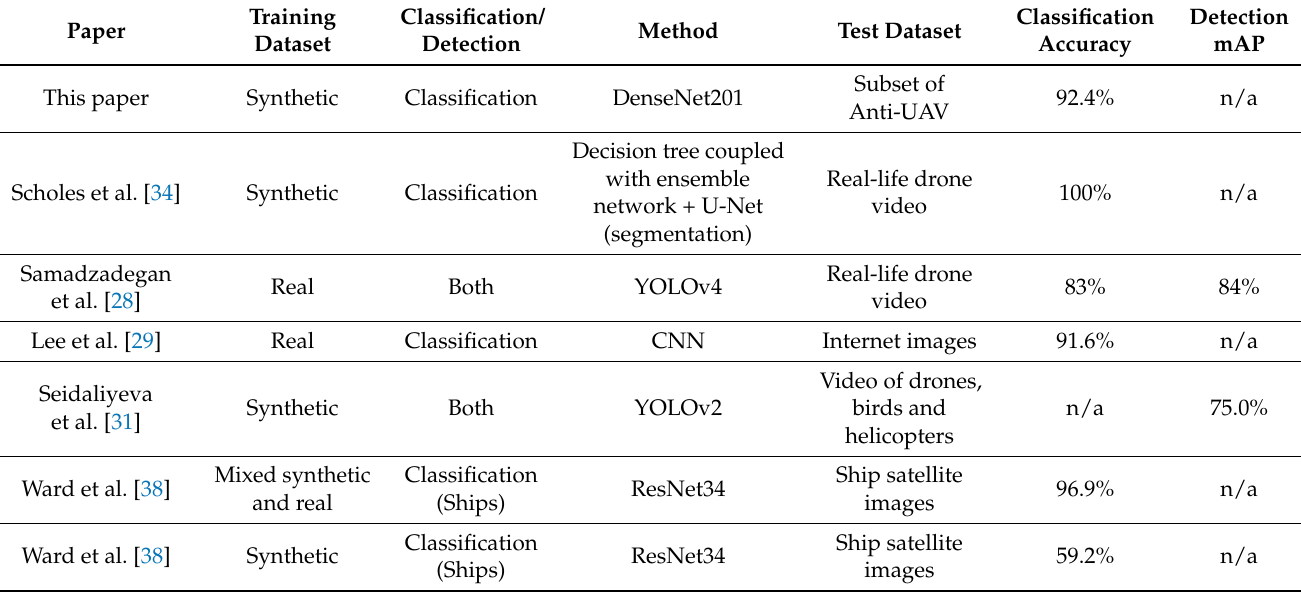
Table 4. Comparison of visual drone detection and classification results with literature. One exception is Ward et al., who classified ships instead of drones, but because they used a synthetic dataset, it makes their results a useful